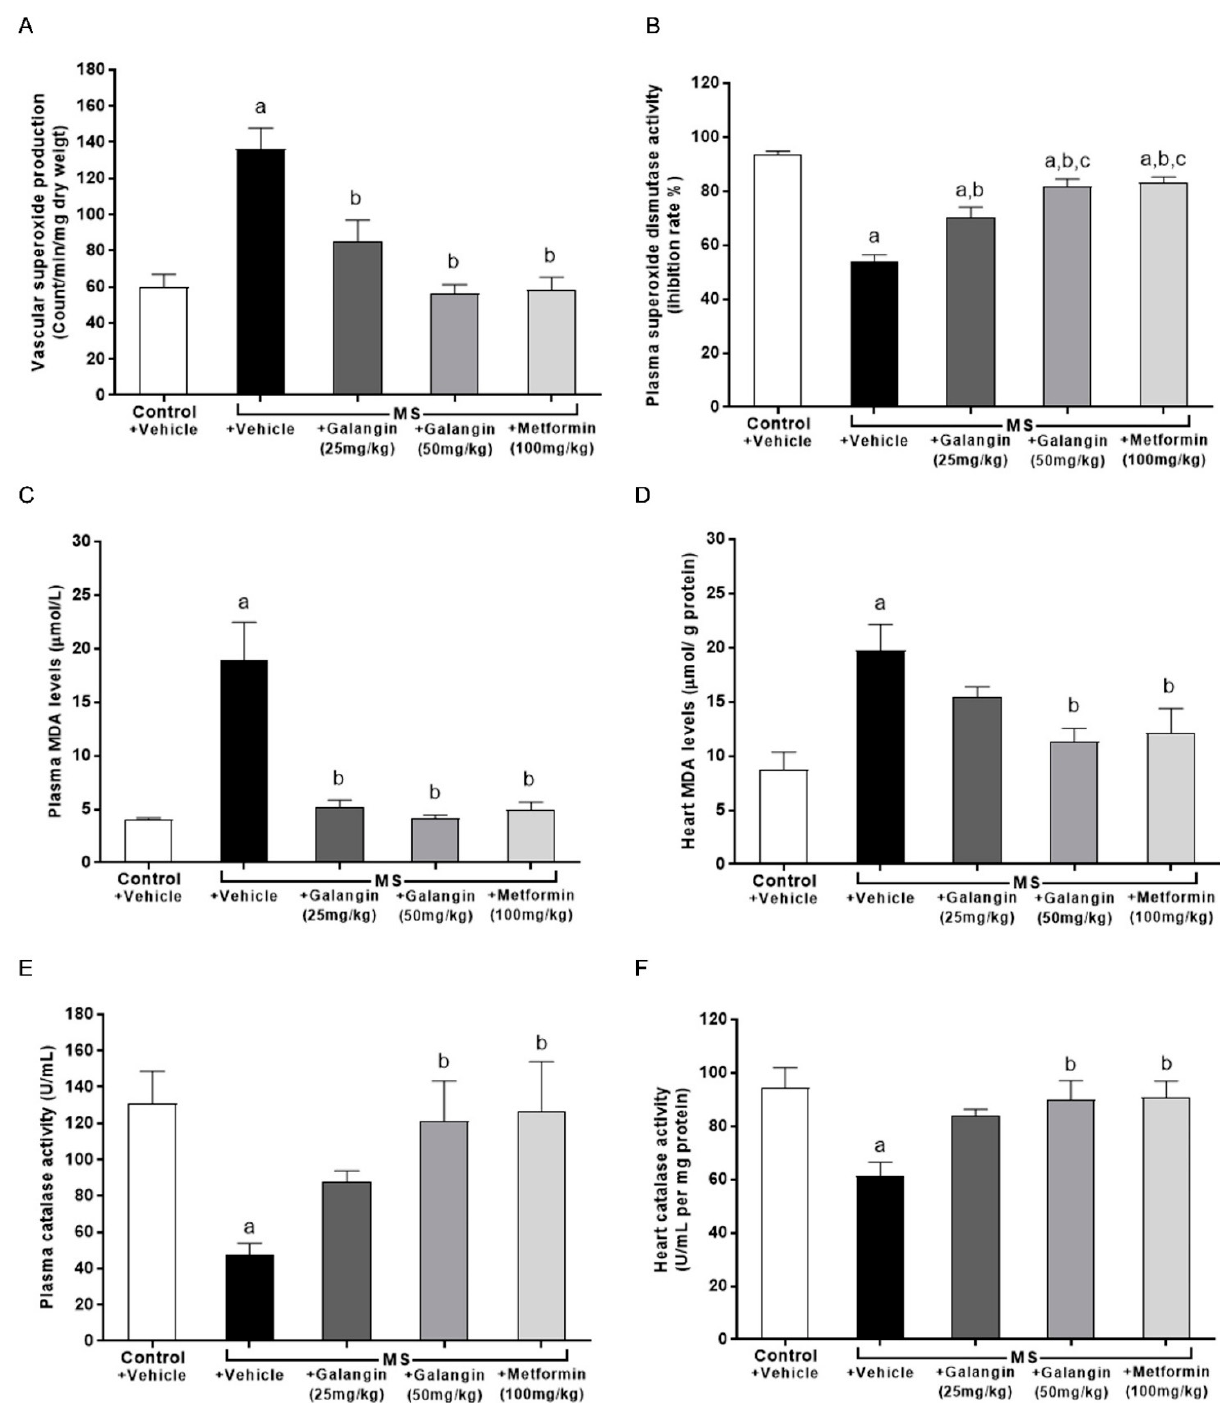
Figure 7. Effects of galangin and metformin treatments on oxidative stress markers and endogenous antioxidant enzymes. ( A ) Aortic superoxide production, ( B ) plasma malondialdehyde (MDA) level, ( C ) heart MDA level ( D ) plasma superoxide dismutase (SOD) activity, ( E ) plasma catalase (CAT) activity, and ( F ) heart CAT activity. Results are shown as the mean ± S.E.M. ( n = 8). a p < 0.05 vs. the control group, b p < 0.05 vs. the MS group, and c p < 0.05 vs. the MS + galangin (25 mL/kg) group.